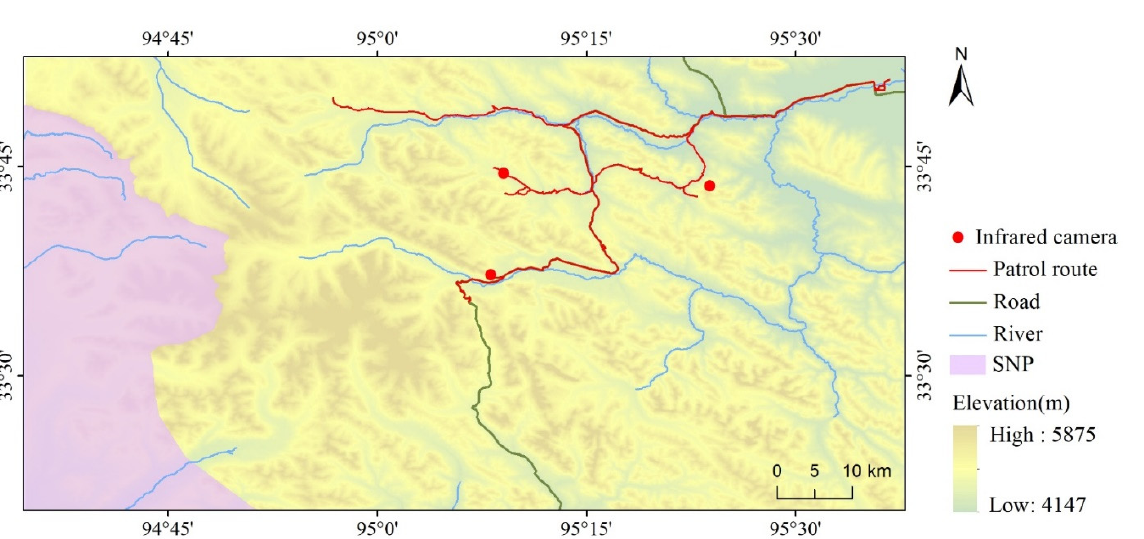
( b ) Figure 4. Photo records of snow leopards breaking into human settlements. ( a ) Occurred in the day; ( b ) Occurred in the night. Based on the same method, we counted the habitats of snow leopards in Sanjiang- yuan region. The snow leopard habitat consisted of 85,778 km 2 , accounting for 23.4% of the total areas in Sanjiangyuan. Most of the snow leopards’ potential habitats are located outside the national park, mainly including the areas east of Lancang River National Park and the areas east and south of the Yellow River National Park. Moreover, habitats inside the national park concentrate in the southeast of Lancang River National Park. Thus, it seems urgent to adapt and adjust the national park boundaries to these snow leopard habitats. 4.2. Snow Leopard Habitat Changes under Climate Scenarios A likely significant factor in assessing the future boundaries of a national park is cli- mate change [21]. As shown in Table 3, we divided the landscape types of Sobchaye into three categories, namely ‘vegetation’, ‘bare rock’, and ‘glacial area’, and compared these types with three major indicators of climate change, namely ‘temperature’, ‘precipitation’, and ‘sunshine duration’. The category of ‘vegetation’ was further divided into three sub- groups, namely ‘high-coverage vegetation’, ‘medium-coverage vegetation’, and ‘low-cov- erage vegetation area’. The results showed that the bare rock area has increased by 6.7% from 2010 to 2020. In contrast, the vegetation and glacial areas have decreased by 2.1%